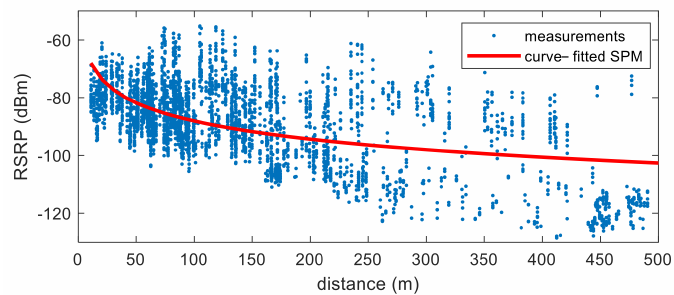
Figure 1. RSRP measurements and results of SPMing performed based on